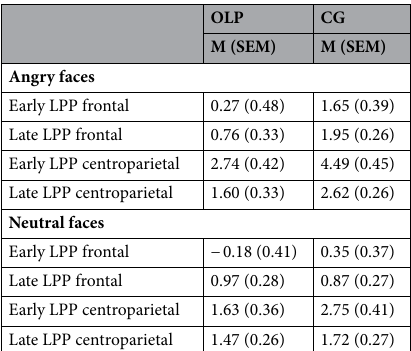
Figure 1. Means and standard errors for picture ratings (valence, arousal, anger intensity) by the open-label placebo (OLP) group and the control group (CG). OLP